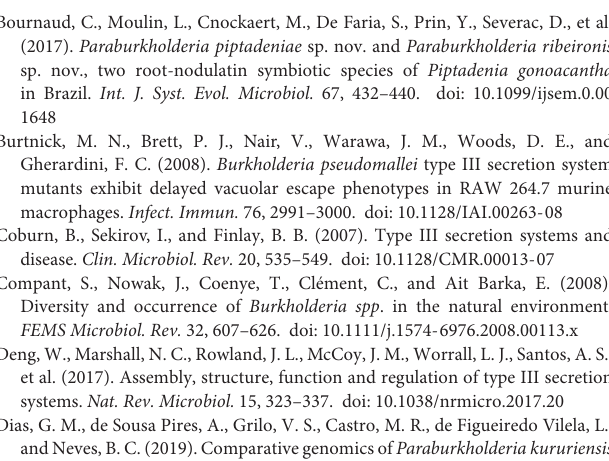
Supplementary Figure 1 | Synteny conservation within T3SS types across Burkholderia s.l. strains. Supplementary Figure 2 | Distribution of BCI and PSI types outside Burkholderia s.l. species. (A) Concatenated SctC, SctN, SctT and SctV sequences from the